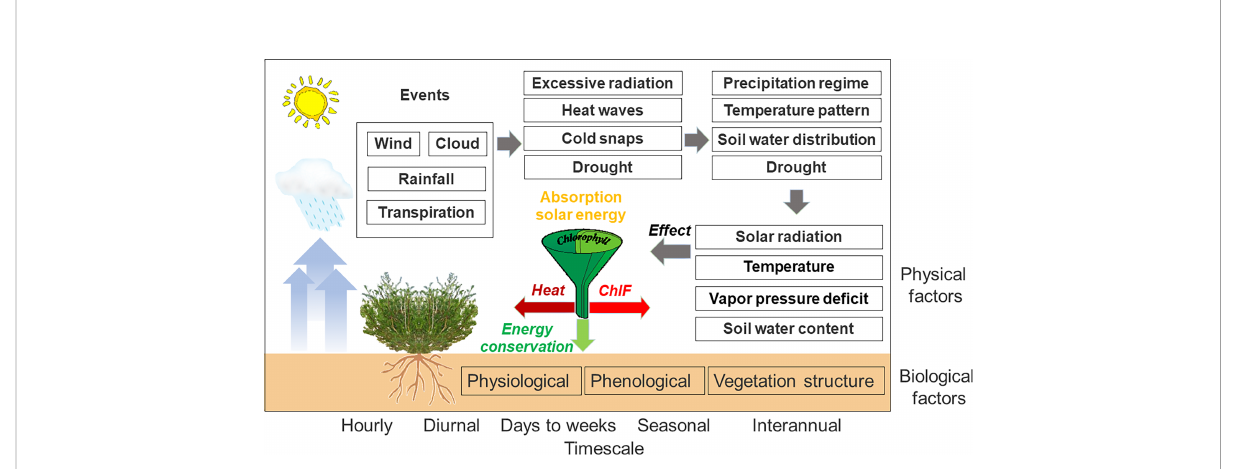
FIGURE 1 A conceptual description of biophysical factors that drive PSII-energy partitioning over multiple timescales. Drivers of PSII-energy partitioning included in this diagram are by no means